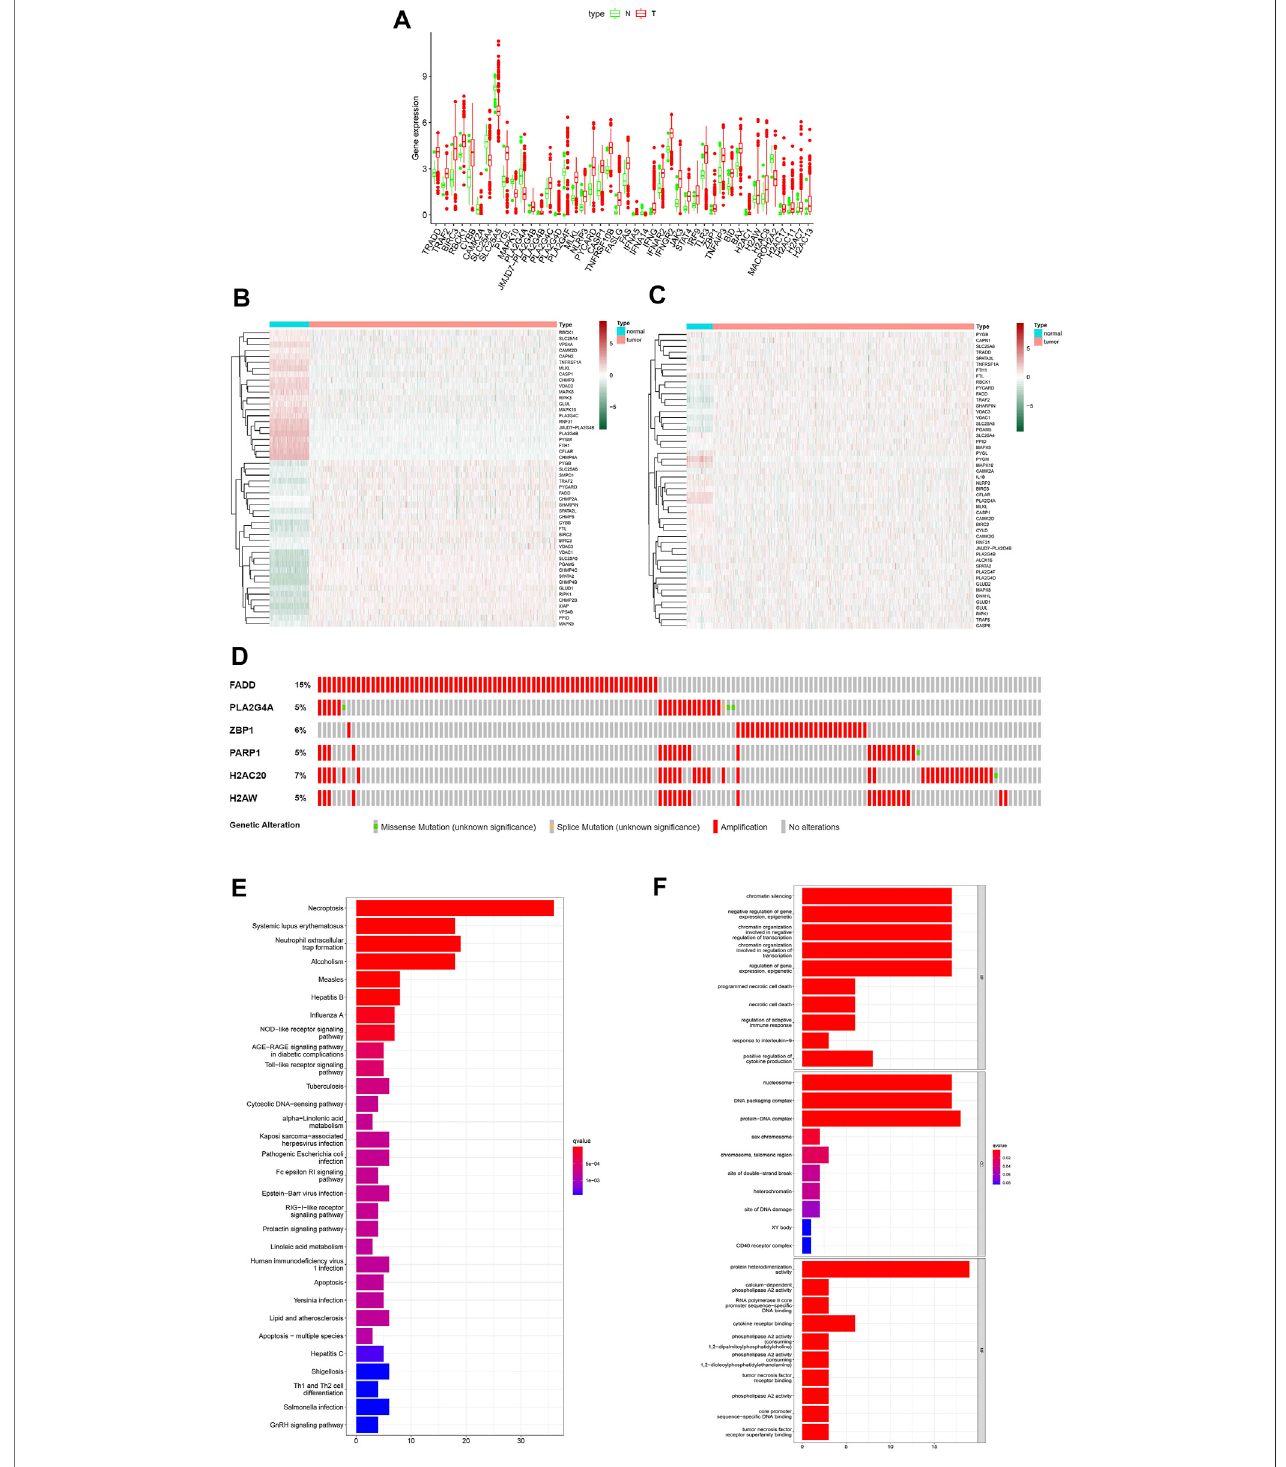
FIGURE2| Differentialgeneticanalysis.Boxplotsindicategenesthatareabnormallyexpressedintumortissuecompared toadjacentnormaltissue (A) ,Heatmap of the top 50 different expressions gene between tumor tissue and GTEx normal breast tissue (B) , Heat map of the top 50 different expressions gene between tumor tissue and adjacent normal tissue in patients (C) . Probability of chromosomal mutations in differentially expressed genes (D) , The top 30 signi fi cant terms of KEGG analysis (E) The top 30 signi fi cant terms of GO function enrichment. BP biological process, CC cellular component, MF molecular function (F) .